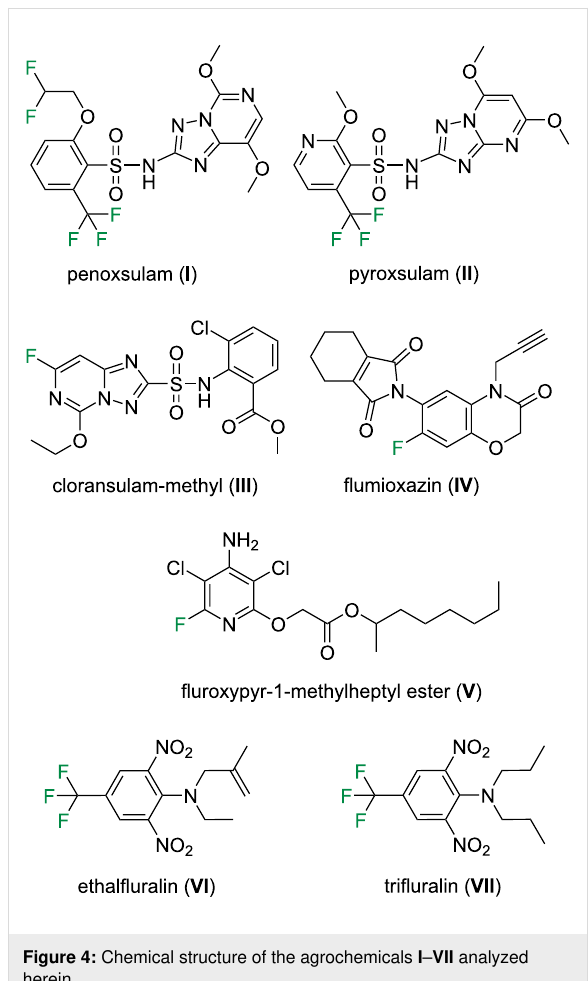
Figure 4: Chemical structure of the agrochemicals I – VII analyzed